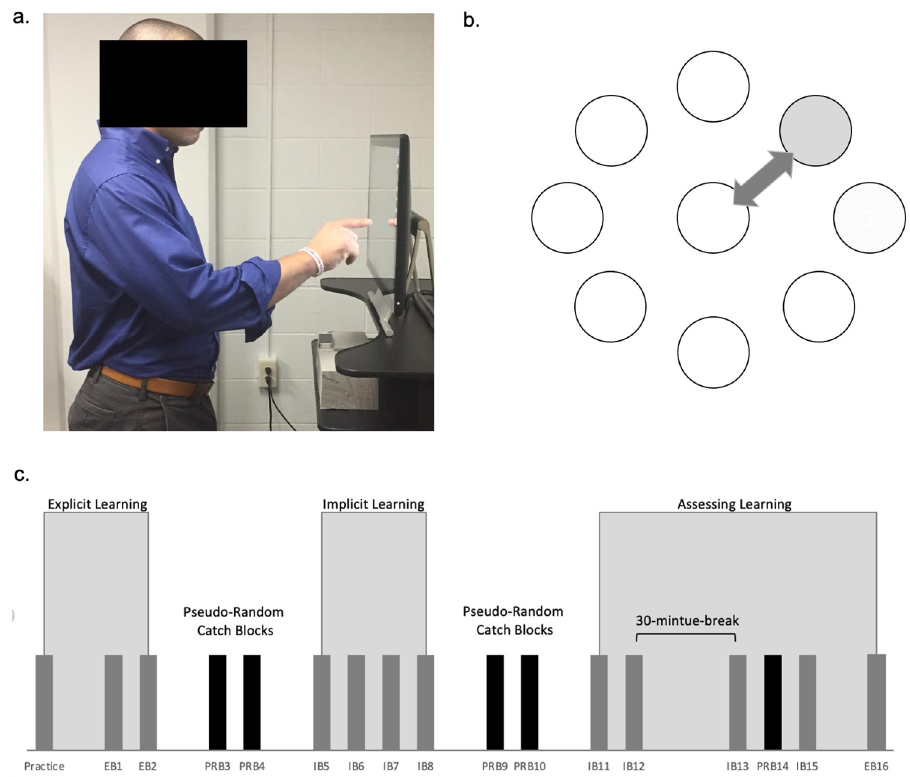
Fig 1. Motor learning set up and paradigm. (a) Position of participant during serial reaching task. (b) Illustration of arrangement of targets. The peripheral target (grey circle) would illuminate red indicating to the participant to reach to that target. After each reach to a peripheral target, the center target would turn red (empty circle) indicating to return to the center target. (c) Illustration of blocks of reaching movements in paradigm EB = explicit block, IB = implicit block, PRB = pseudo-random